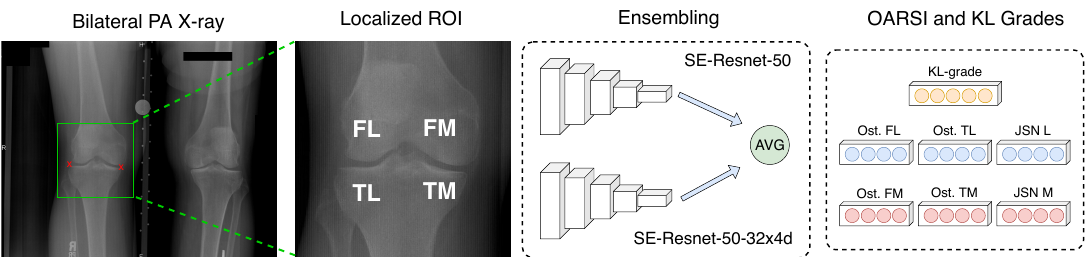
Figure 2. Schematic representation of the workflow of our approach. We used transfer learning from ImageNet and trained two deep neural network models, averaged their predictions and predicted totally six knee joint radiographic features according to the OARSI grading atlas as well as a the KL grade. OARSI grades for osteophytes in femoral lateral (FL), tibial-lateral (TL), femoral-medial (FM) and tibial-medial (TM) compartments as well as the joint space narrowing (JSN) grades in lateral and medial compartments were